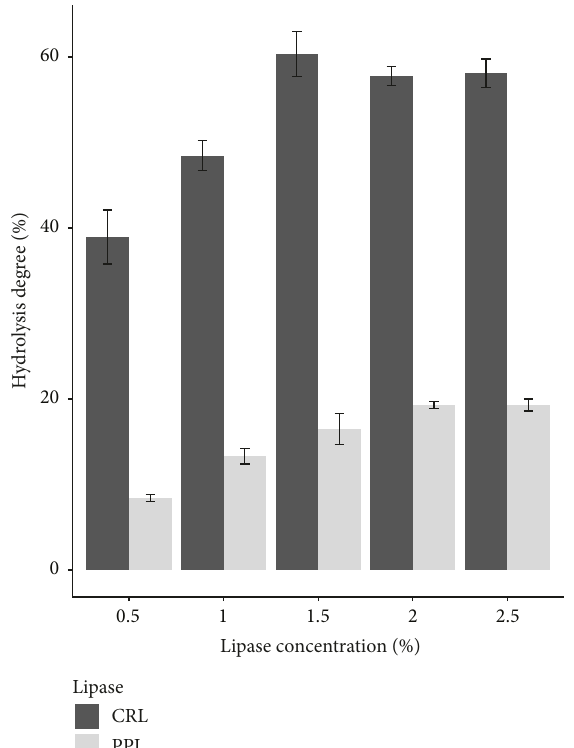
Figure 2: Effect of lipase concentration on hydrolysis degree of two lipase types.